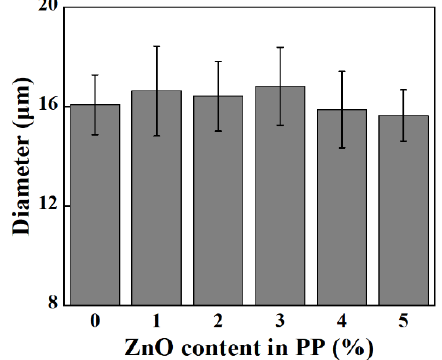
Figure 3. Average diameter of e-spun PP fibers.